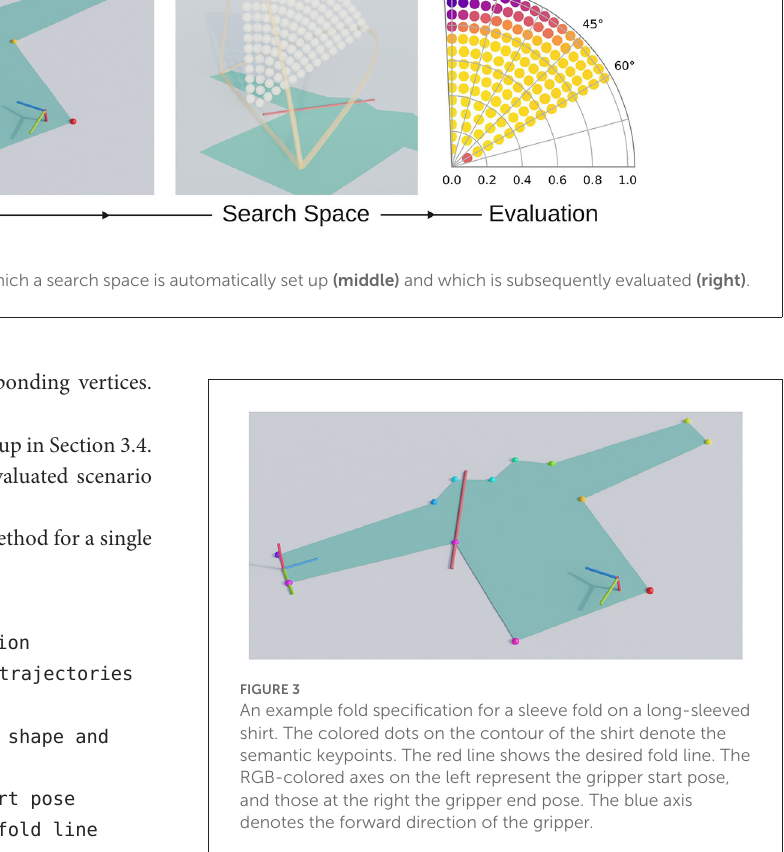
Algorithm 1. Evaluation procedure for a single scenario